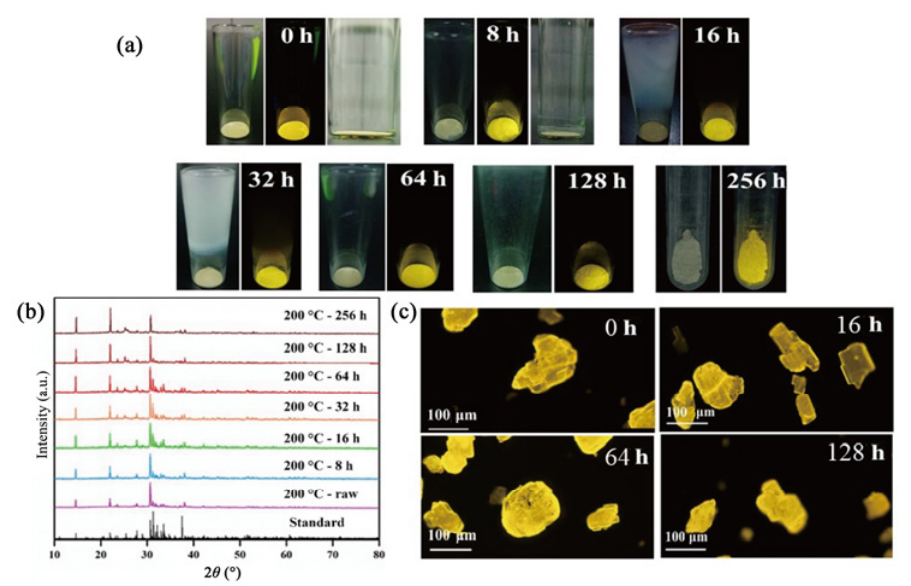
Fig. 7 (a) Photographs (left: under natural light; right: under UV light); (b) XRD patterns; and (c) fluorescent images of Sr 2.97 Si 8 O 4 N 10 :0.03Eu 2+ sample aged at 200 and 100% humidity for varying ℃ time.